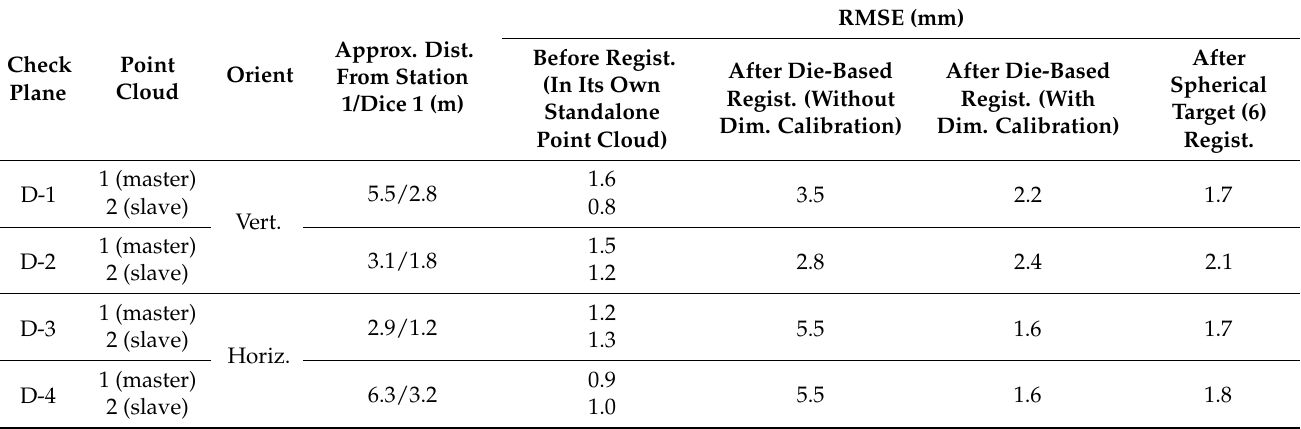
Table 5. RMSEs of check plane residuals before and after the registration. (Dataset D, die